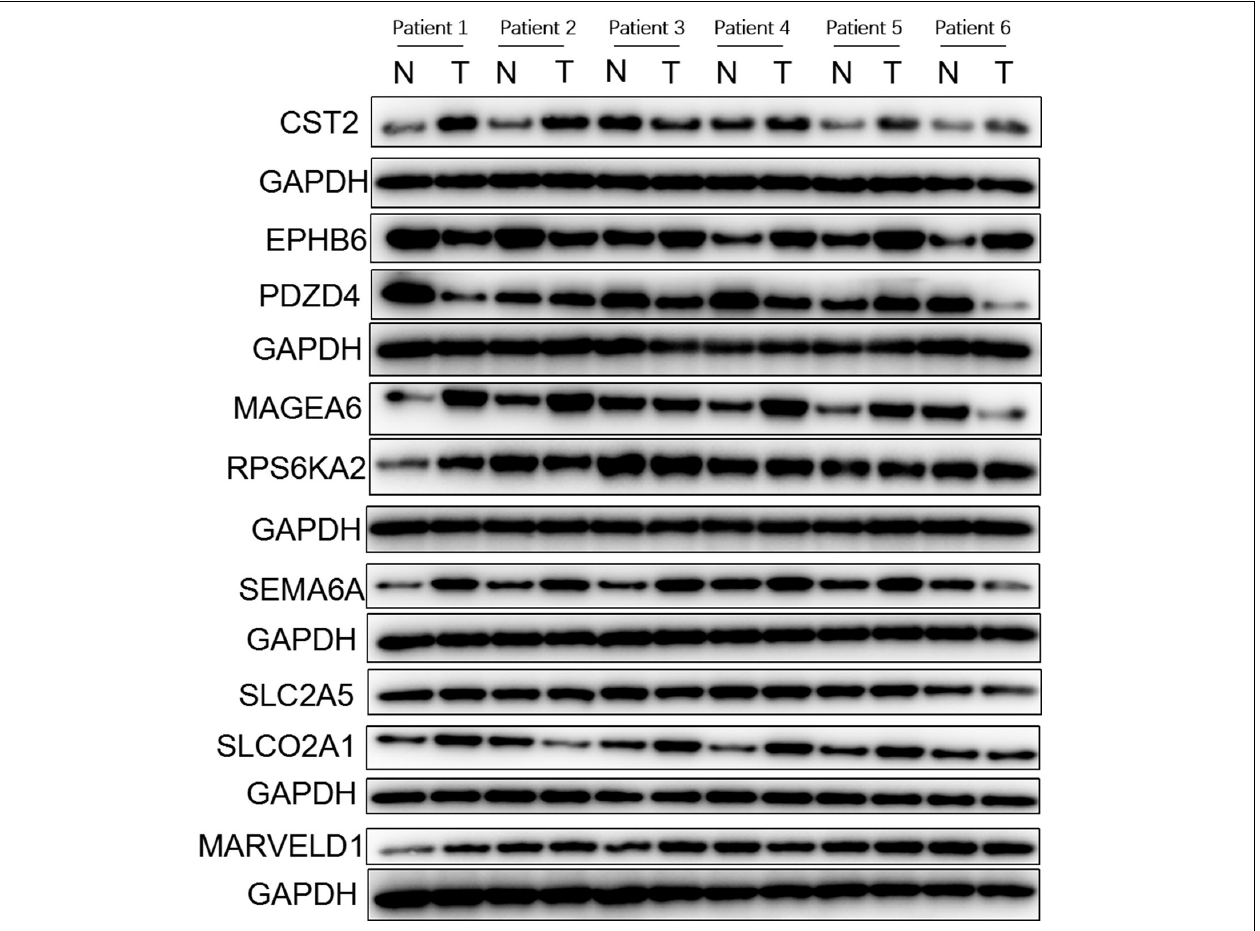
FIGURE 7 | Protein expression profiles of genes in the GIGSig analyzed based on normal and tumor tissues from six patients diagnosed with HCC in the institute of The First Affiliated Hospital of Sun Yat-sen University between the years June 2019 to December 2019. N, normal tissue; T, tumor